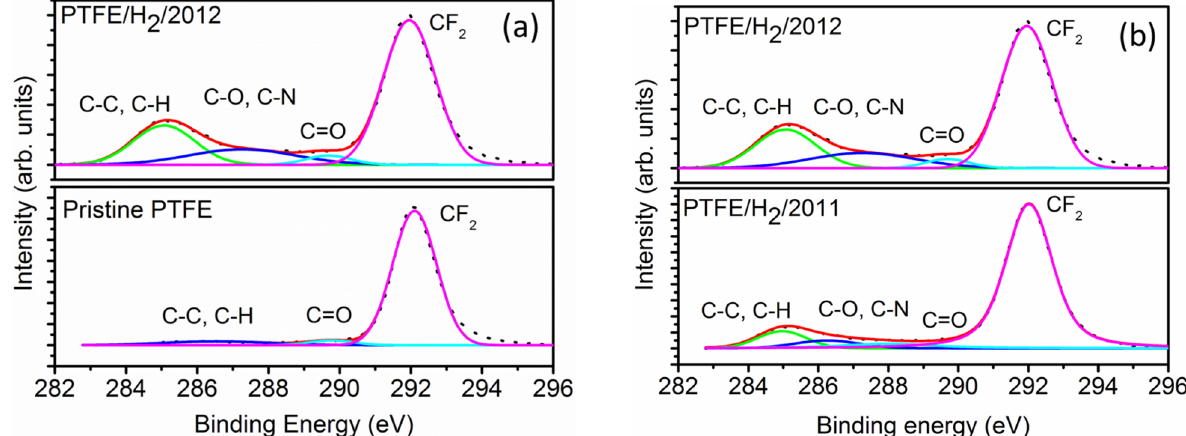
Figure 2. ( a ) High resolution C1s spectra of pristine and H 2 plasma treated PTFE